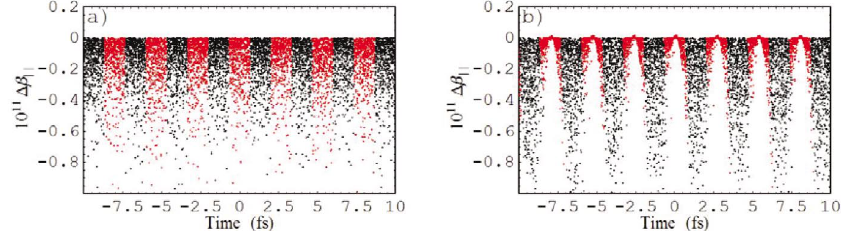
FIG. 4. (Color) The FODO channel with (cid:25) functions.